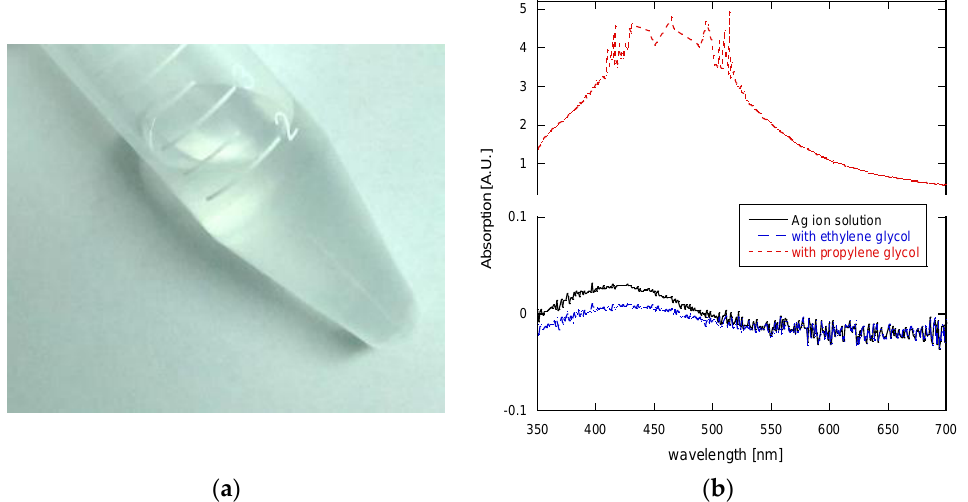
Figure 1. ( a ) The silver ion reaction solution used in this study; and ( b ) The absorbance spectrum